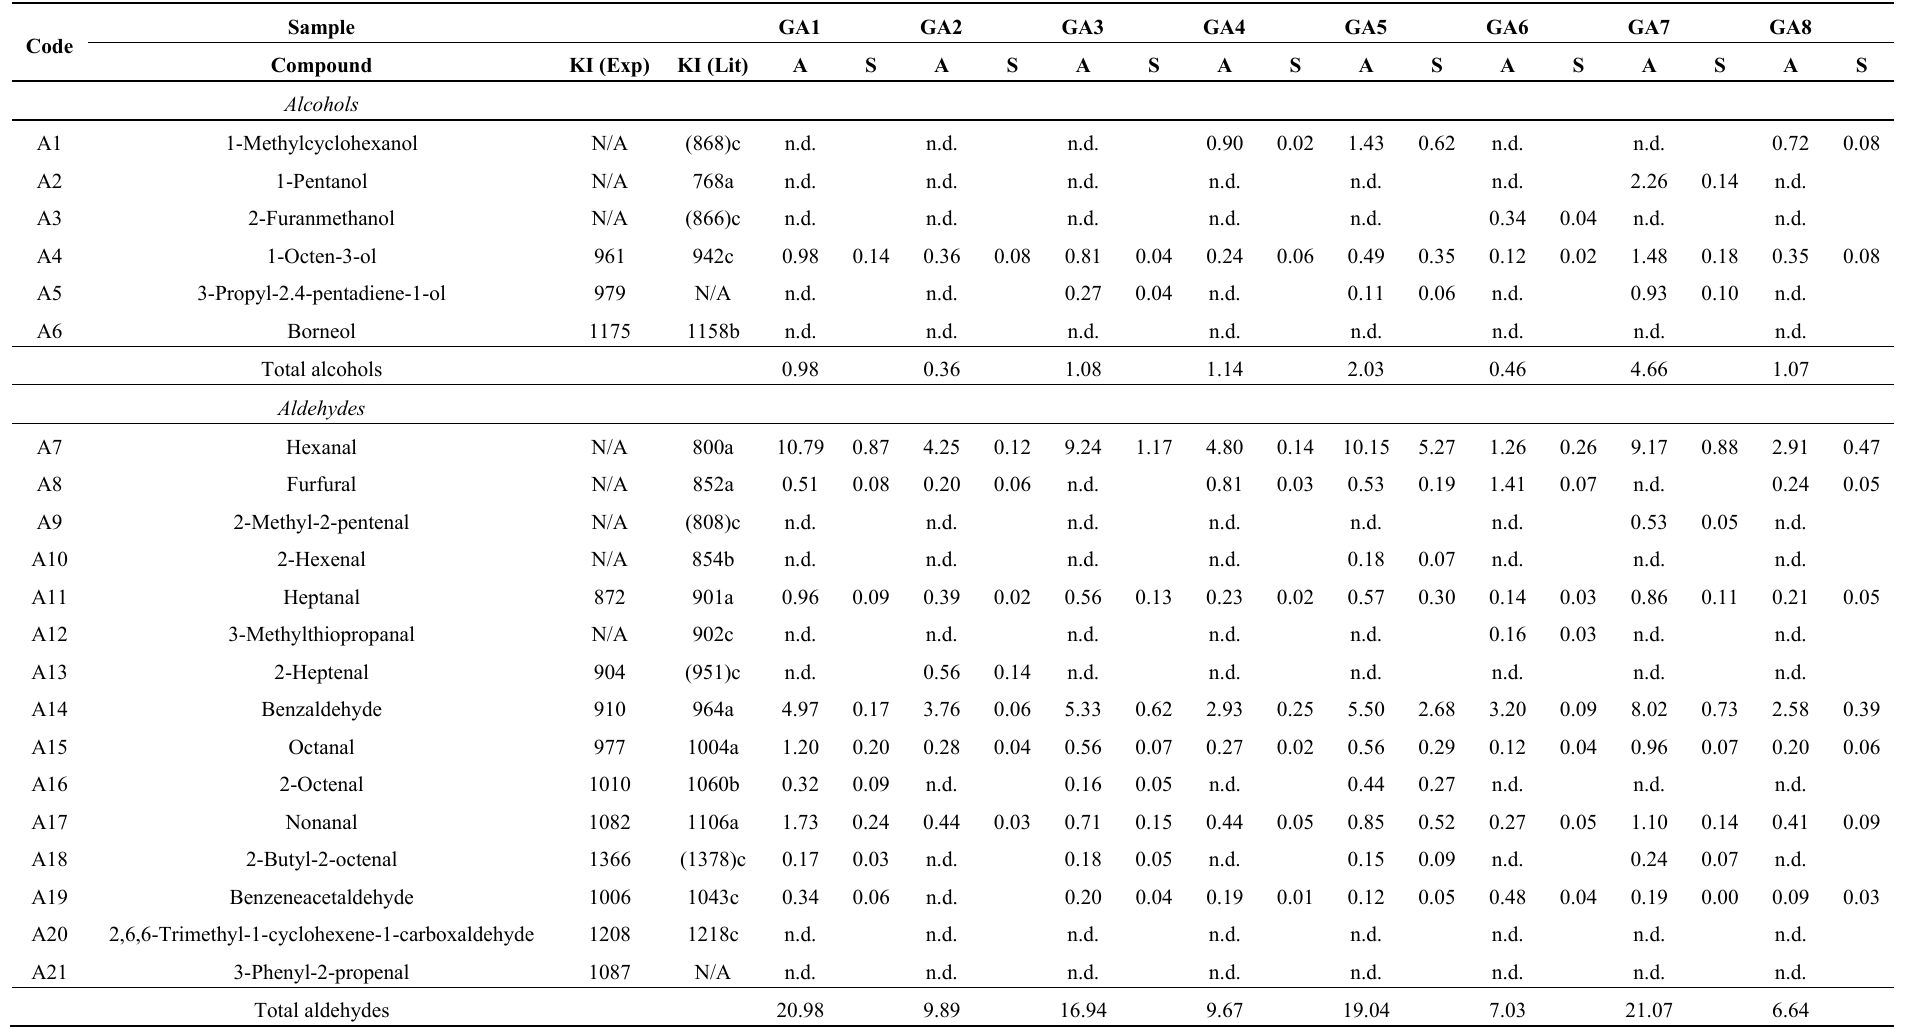
Table 2. Content (µg/kg) of aroma compounds in grain-added dog food